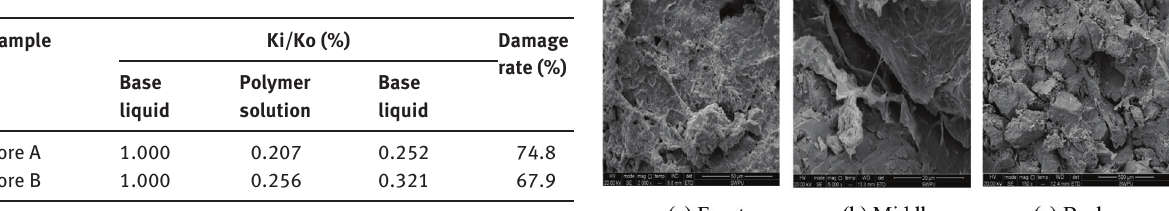
Figure 3: Permeability of cores at different polymer injection volume. Table 4: Permeability damage rate.